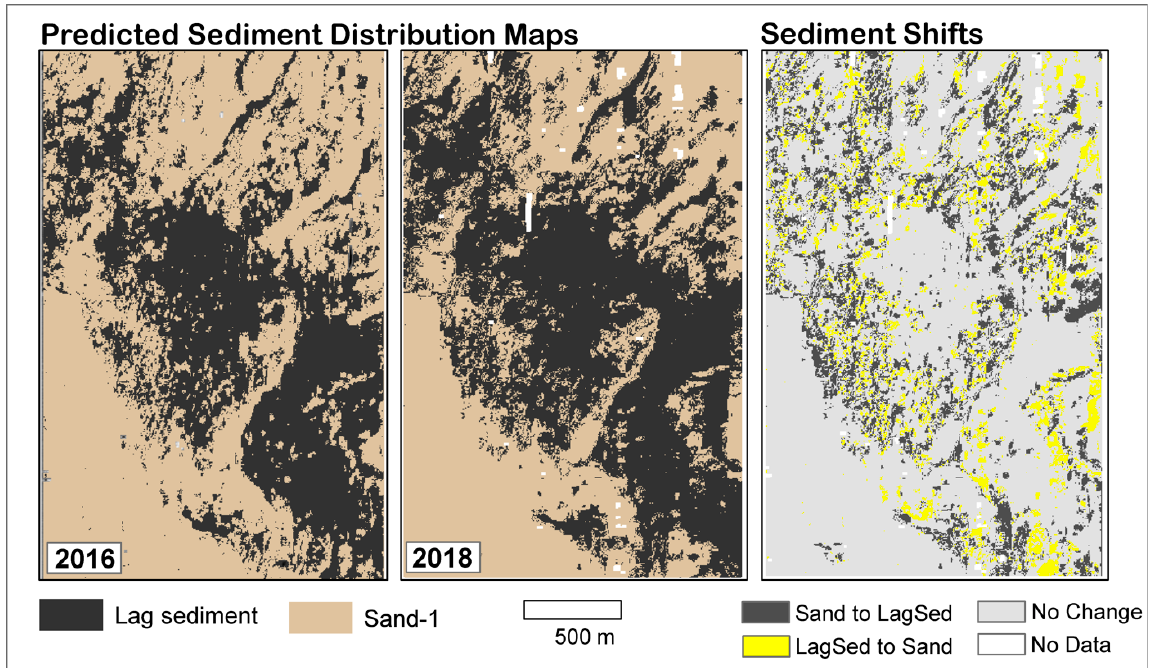
Figure 6. Seafloor sediment distribution maps of H3 and the sediment shifts that occurred between 2016 and 2018 (17 months apart). Table 6. Statistical summary of the accuracy assessments of the ensemble maps.